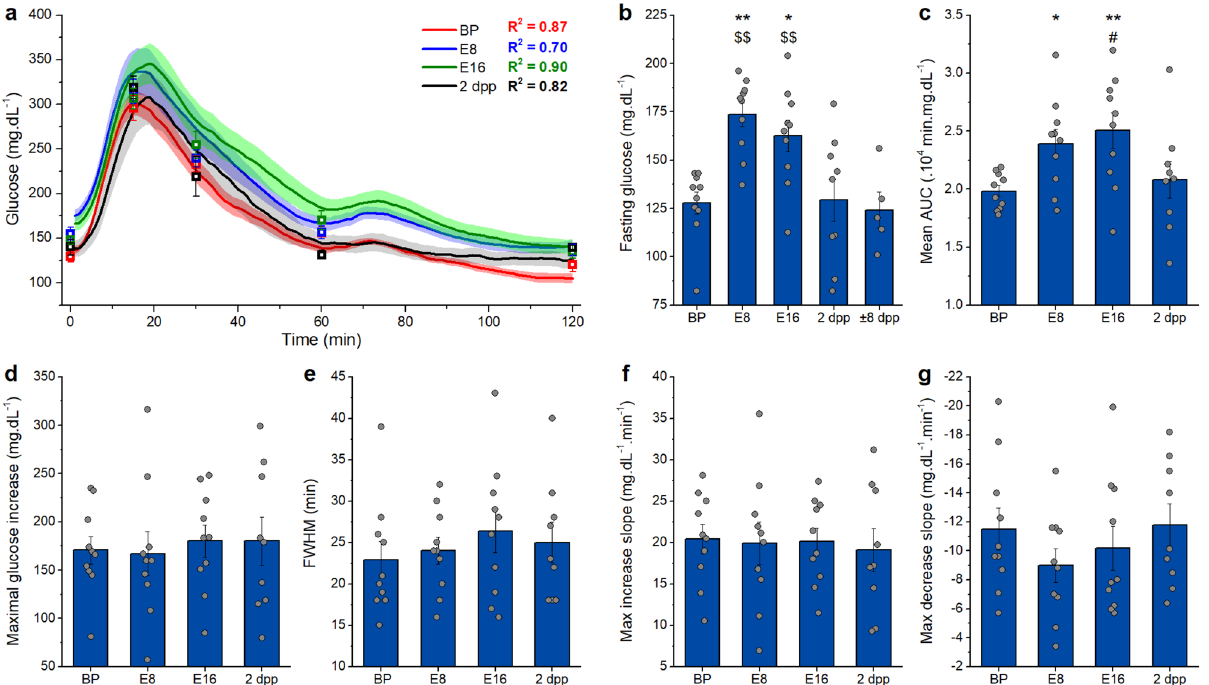
Figure 3. OGTT in transmitter group via telemetry. ( a ) Average traces ± s.e.m. of the OGTTs before (BP), at E8, at E16 and after pregnancy (2 dpp) and their correlation with the manually measured glucose values shown in squares (Linear fit, R 2 ). ( b ) Fasting glucose, arithmetic mean ± s.e.m., changes significantly over the course of pregnancy. *: difference compared to BP, $: difference compared to ± 8dpp. ( c ) AUC, arithmetic mean ± s.e.m., changes significantly over the course of pregnancy.*: difference compared to BP, #: difference compared to 2dpp. ( d ) Amplitude, arithmetic mean ± s.e.m., does not change significantly over the course of pregnancy. ( e ) Full width at half maximum (FWHM), arithmetic mean ± s.e.m., does not change significantly over the course of pregnancy. ( f ) Maximum slope of glucose uptake, arithmetic mean ± s.e.m., during an OGTT does not change significantly over the course of pregnancy. ( g ) Maximum slope of glucose clearance, arithmetic mean ± s.e.m., during an OGTT does not change significantly over the course of pregnancy. ( b – g One-way repeated measures ANOVA, BP, E8, E16: n = 10; 2dpp: n = 9; ± 8dpp: n = 5). See also supplementary Fig.